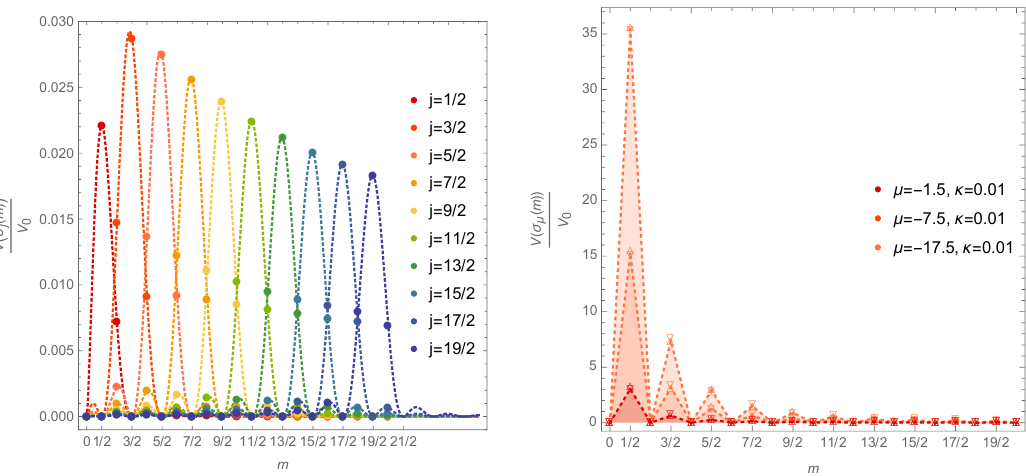
Figure 4. The spectrum to the volume operator in the free case to the left and effectively interacting case to the right. These illustrate that the geometric operators are dominated by the lowest non-trivial modes characterizing the condensate field. These plots were taken from Ref. [92] where a detailed discussion of their underlying computations can be